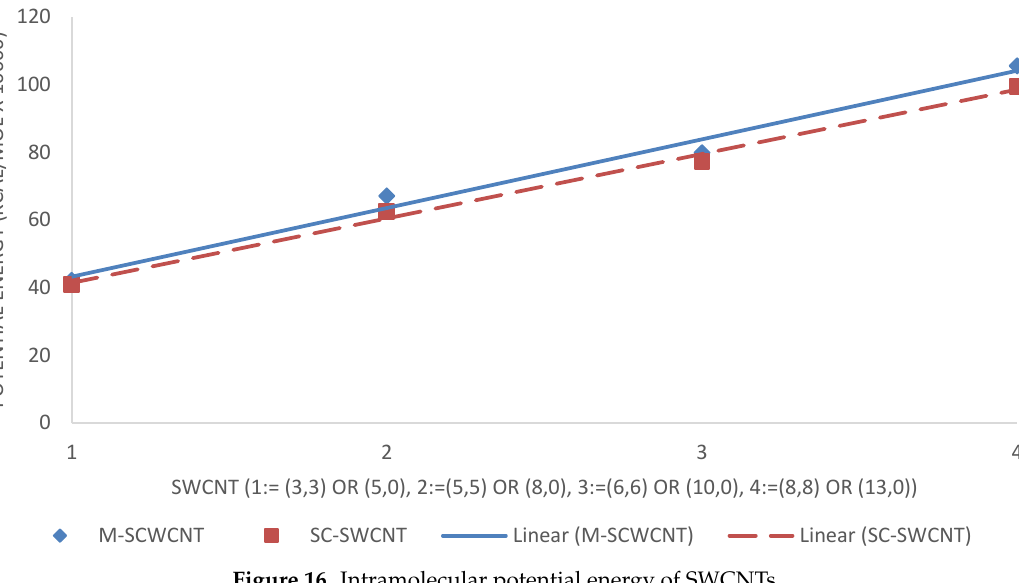
Figure 16. Intramolecular potential energy of SWCNTs.